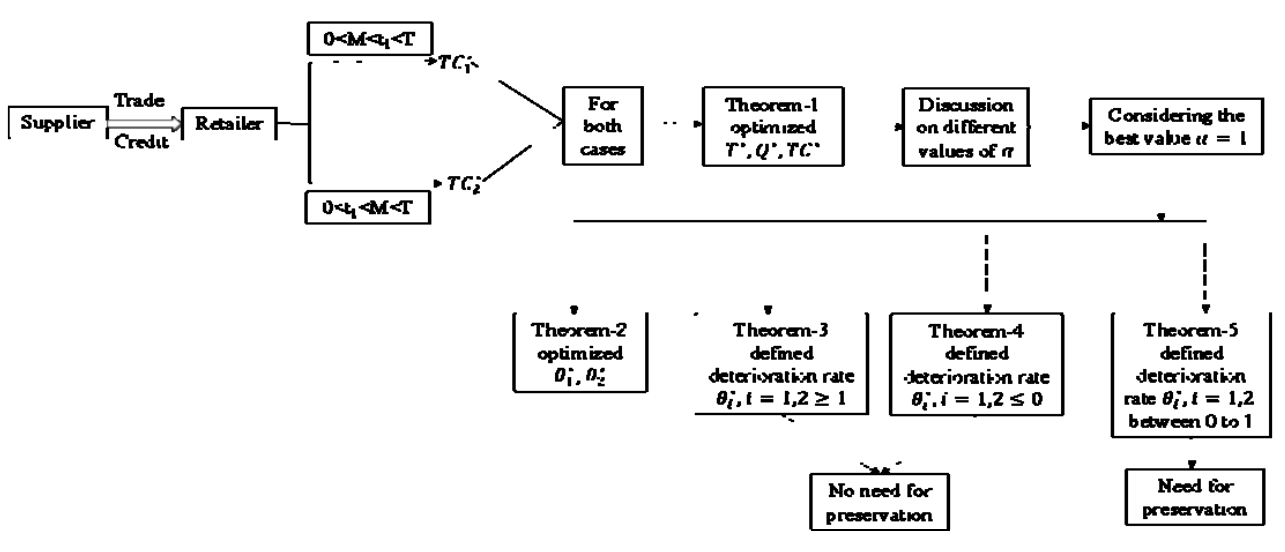
Figure 6. Decision support system for the retailer.